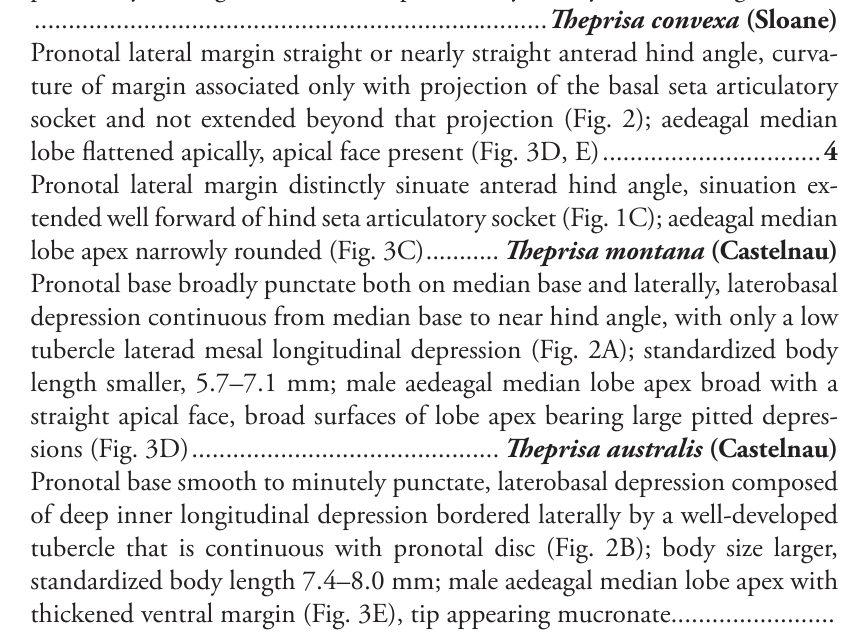
1 Body more gracile, MPW/PL = 1.25–1.34; elytra ovoid to subquadrate, third interval glabrous (Figs 1B, C, 2); prosternum impunctate across anterior sur- – Body broad, MPW/PL = 1.38–1.46; elytra broadly hemi-ovoid, a single seta present mesad third stria at 1/3 elytral length (Fig. 1A); prosternum irregu- larly depressed each side anterad coxal cavity, ~8 punctures associated with transverse to oblique depression; male aedeagal median lobe with broad in- vagination, or divot, along ventral portion of apical margin (Fig. 3A) ........... 2 Elytral striae smoother, wavering slightly to straight in deepest portions (Figs 1C, 2); elytral lateral margins subparallel to moderately convex at midlength, HuW/MEW = 0.64–0.67; pronotal basal margin straight to tris- inuate, margin behind laterobasal depressions not distinctly angled anteriorly relative to median base; aedeagal median lobe apex blunt apically, not evenly rounded (Fig. 3C–E) .................................................................................. 3 – Elytra striae distinctly crenulate, punctures visibly expanding breadth (Fig. 1B); elytral ovoid, base constricted, humeri narrow, HuW/MEW = 0.60–0.61; pronotal basal margin distinctly angled laterad median base and slightly concave posterad laterobasal depressions, thus median base extended posteriorly; aedeagal median lobe apex broadly, evenly rounded (Fig. 3B) ..... 3 Pronotal lateral margin straight or nearly straight anterad hind angle, curva- ture of margin associated only with projection of the basal seta articulatory socket and not extended beyond that projection (Fig. 2); aedeagal median lobe flattened apically, apical face present (Fig. 3D, E) ................................ 4 – Pronotal lateral margin distinctly sinuate anterad hind angle, sinuation ex- tended well forward of hind seta articulatory socket (Fig. 1C); aedeagal median lobe apex narrowly rounded (Fig. 3C) ........... Theprisa montana (Castelnau) 4 Pronotal base broadly punctate both on median base and laterally, laterobasal depression continuous from median base to near hind angle, with only a low tubercle laterad mesal longitudinal depression (Fig. 2A); standardized body length smaller, 5.7–7.1 mm; male aedeagal median lobe apex broad with a straight apical face, broad surfaces of lobe apex bearing large pitted depres- sions (Fig. 3D) ............................................. Theprisa australis (Castelnau) – Pronotal base smooth to minutely punctate, laterobasal depression composed of deep inner longitudinal depression bordered laterally by a well-developed tubercle that is continuous with pronotal disc (Fig. 2B); body size larger, standardized body length 7.4–8.0 mm; male aedeagal median lobe apex with thickened ventral margin (Fig. 3E), tip appearing